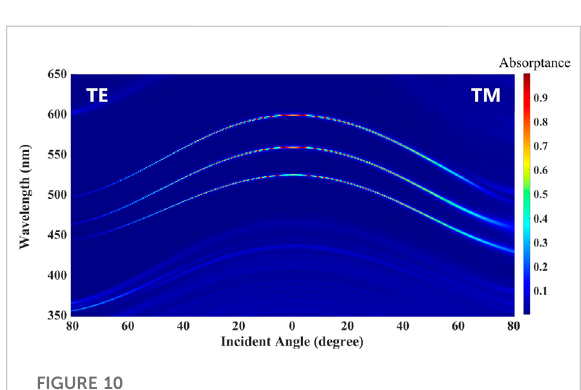
FIGURE 10 Absorptionspectraof(AB) 5 D(BA) 2 D(AB) 2 D(BA) 20 withdifferent incident angles for TE and TM polarizations. All parameters are the same as those used in Figure